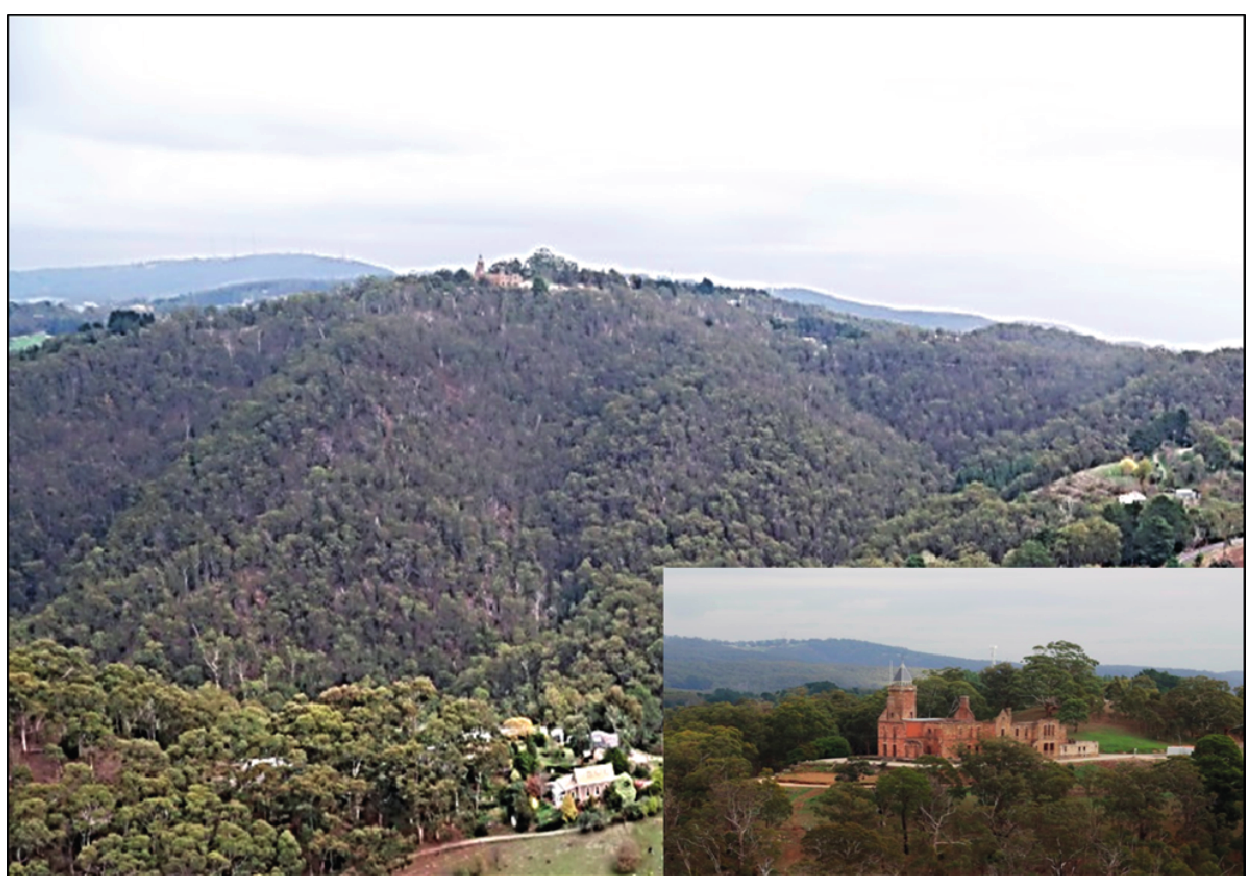
Figure 7. Ruins of the Governor’s hilltop mansion, Marble Hill (inset). Cherryville is in the foreground. (Photos: David J. McKenna, May